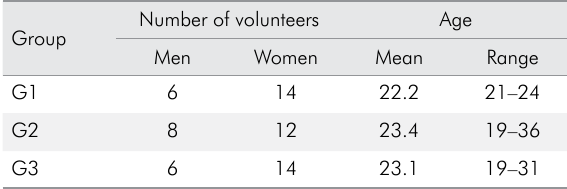
Table 2. Baseline demographic data for subjects starting the